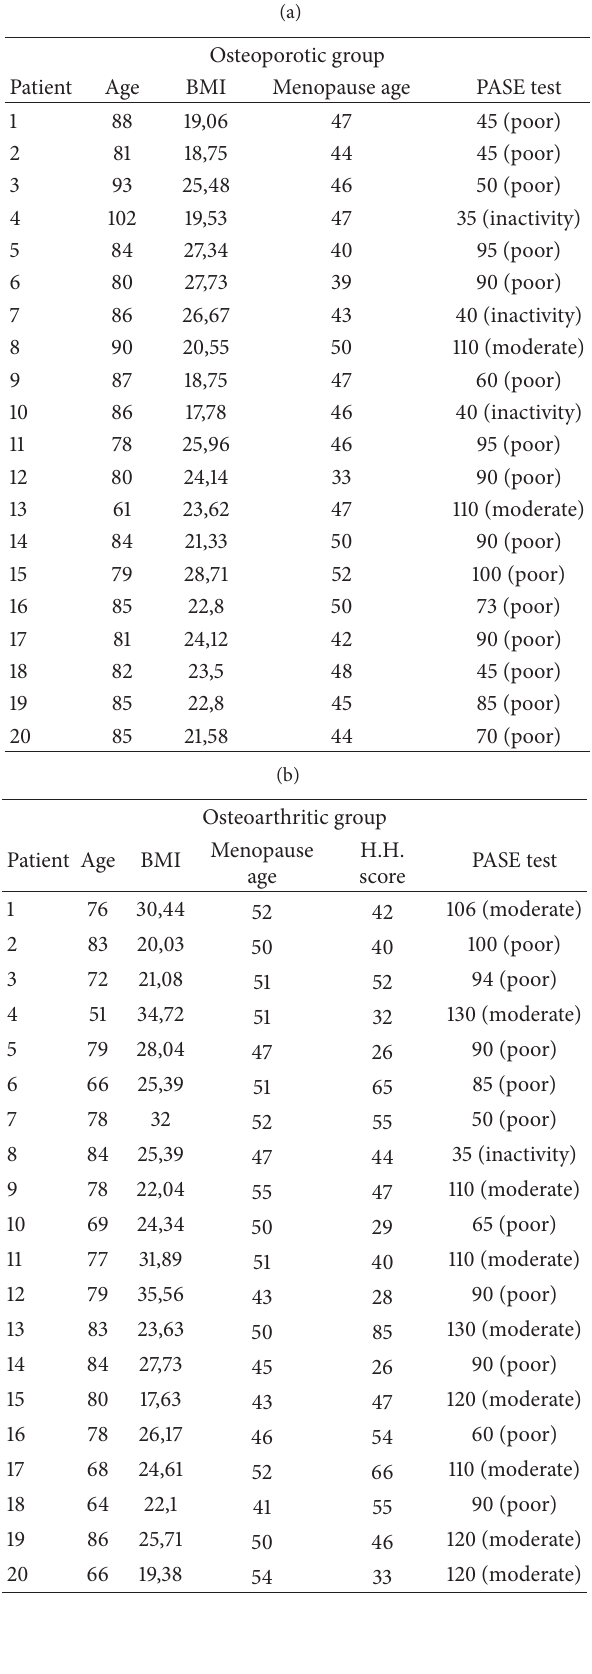
Table 1: (a) Clinical data of Osteoporotic patients. (b) Clinical data of Osteoarthritic